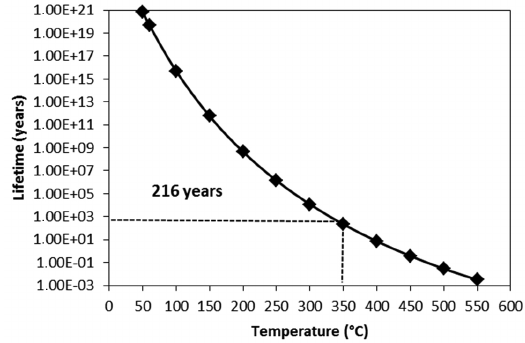
Figure 5. Lifetime versus necessary temperature for the PEEK decomposes in